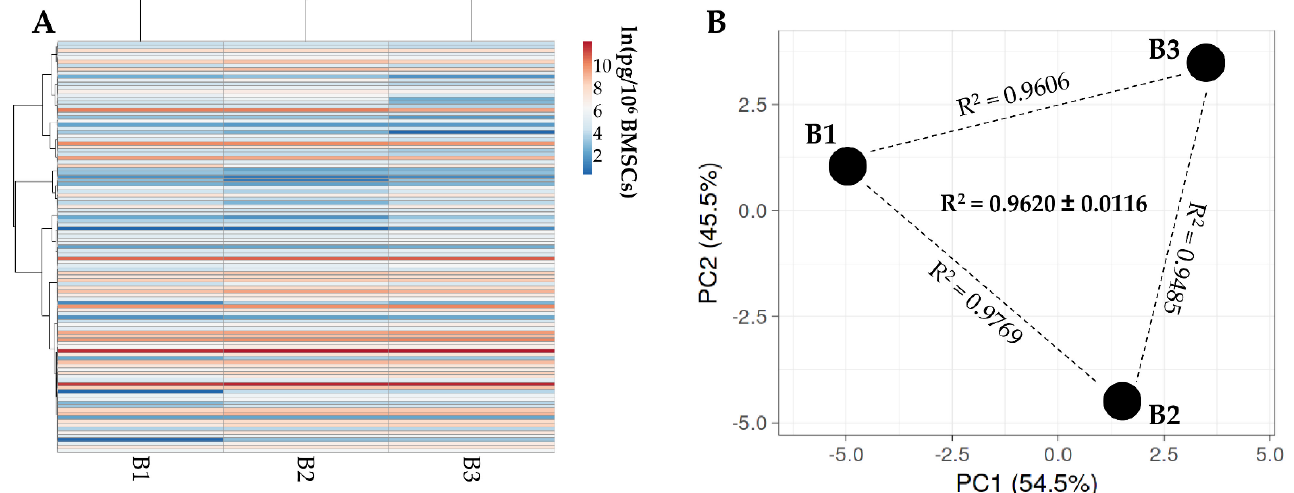
Figure 2. Comparison of secreted factor profiles between BMSCs under study. ( A ), heat map of hierarchical clustering analysis of the ln(x)-transformed pg/million BMSCs values of detected factors with sample clustering tree at the top. Absolute expression levels are indicated by the color scale: blue shades = low expression levels and red shades = high expression levels. ( B ) principal component analysis of the ln(x)-transformed pg/million BMSCs values of detected factors. X and Y axis show principal component 1 and principal component 2 that explain 54.5% and 45.5% of the total variance. Table 1. BMSCs secreted factors detected in all donors and ordered by abundance of the mean val- ues.